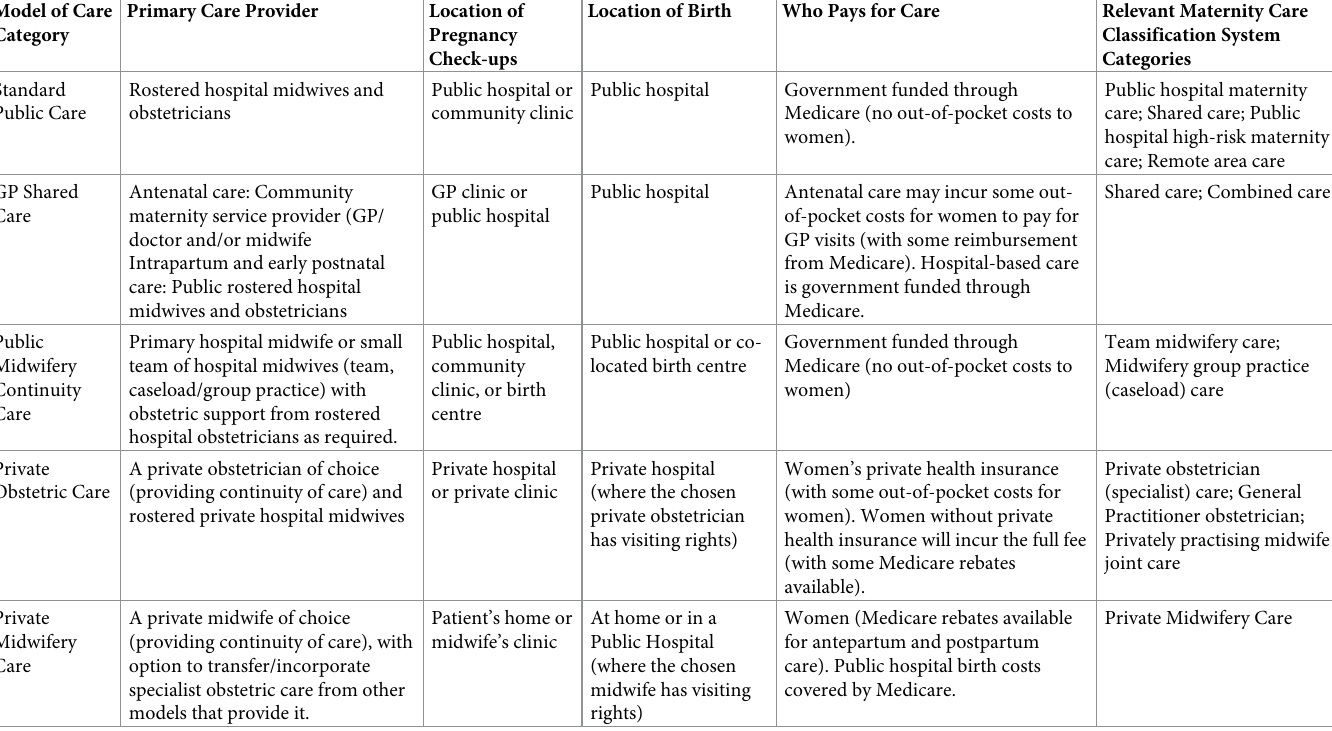
Table 1. Maternity model of care categories and definitions and their relationship to the current Maternity Care Classification System (MaCCS) in Australia [5, 18]. Model of Care